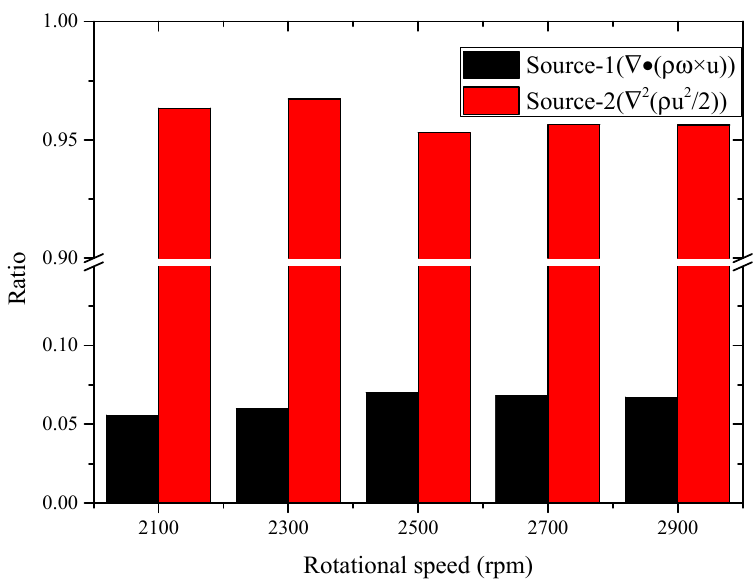
Figure 16. The STD ratios of different acoustic source components under various rotational speeds.